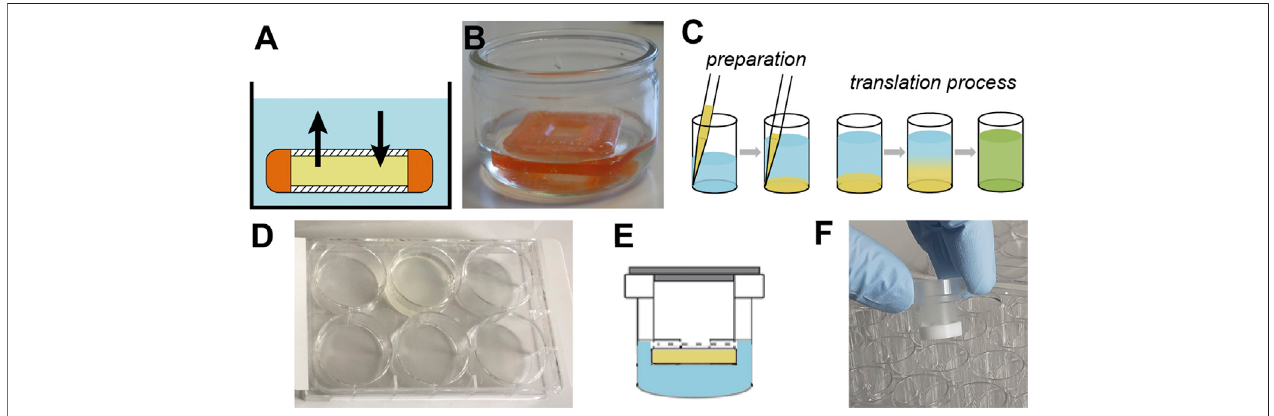
FIGURE5| Differentreactionformatsforproteinexpression usingtheWGS. (A) Schematicrepresentation and (B) pictureofa500 μ Ldialysiscassetteformedium scaleCECFproduction. (C) Schematicrepresentationofthebilayermethodwhichisperformedeitherina96-wellplateforsmall-scaleexpressiontestorina6-wellplate for larger-scale production (D) , adapted from Fogeron et al. (2015a), Fogeron et al. (2015b); Fogeron et al. (2017b). (E) Schematic representation of the dialysis method and (F) picture of a CECF mini-reactor manufactured at ETH Zurich by Andreas Hunkeler in Beat H. Meier ’ s laboratory, according to Schneider et al. (2009). In this reaction format, a 24-well plate is used. For all panels, the translation mix is represented in yellow while the feeding buffer is represented in